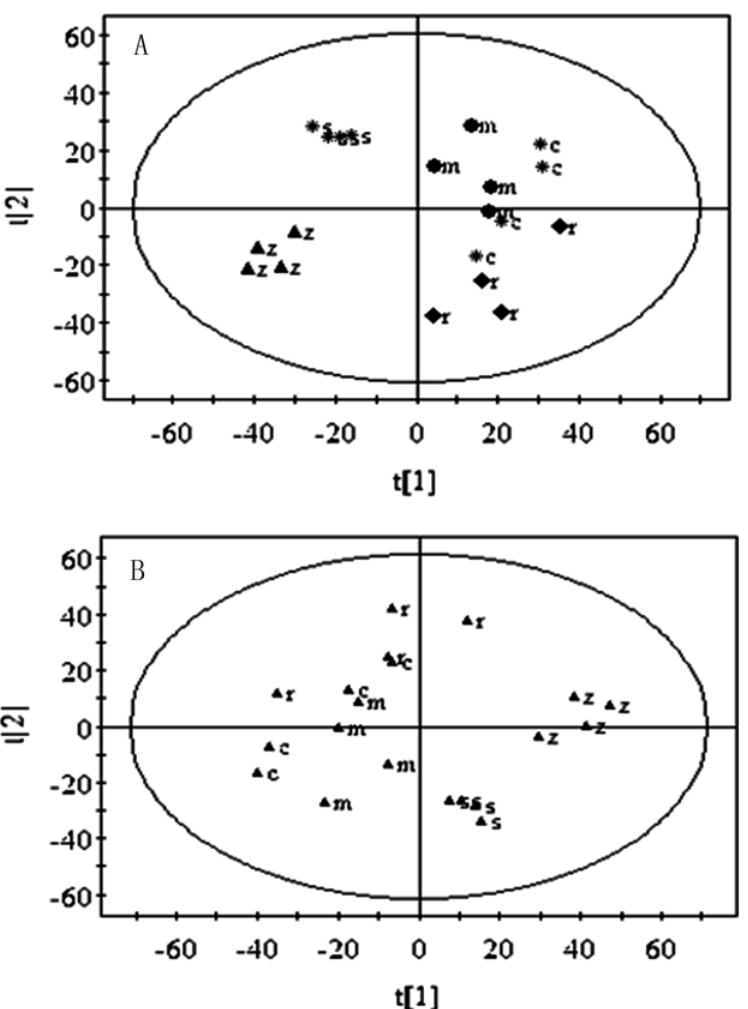
Fig 3. Comparison of wine discrimination derived from the 1 H NMR spectra. (A) PCA Scores Plot (t1/t2), R 2 X = 0.959, Q 2 = 0.872. PC1/PC2 accounted for 65.9% of the total variance. (B) PLS-DA Scores Plot (t1/t2), R 2 X = 0.959, R 2 Y = 0.991, Q 2 = 0.954. PC1/PC2 accounted for 65.5% of the total variance. Grape cultivars: m, Merlot; s, Syrah; z, Zinfandel; r, Ruby Cabernet; c, Cabernet